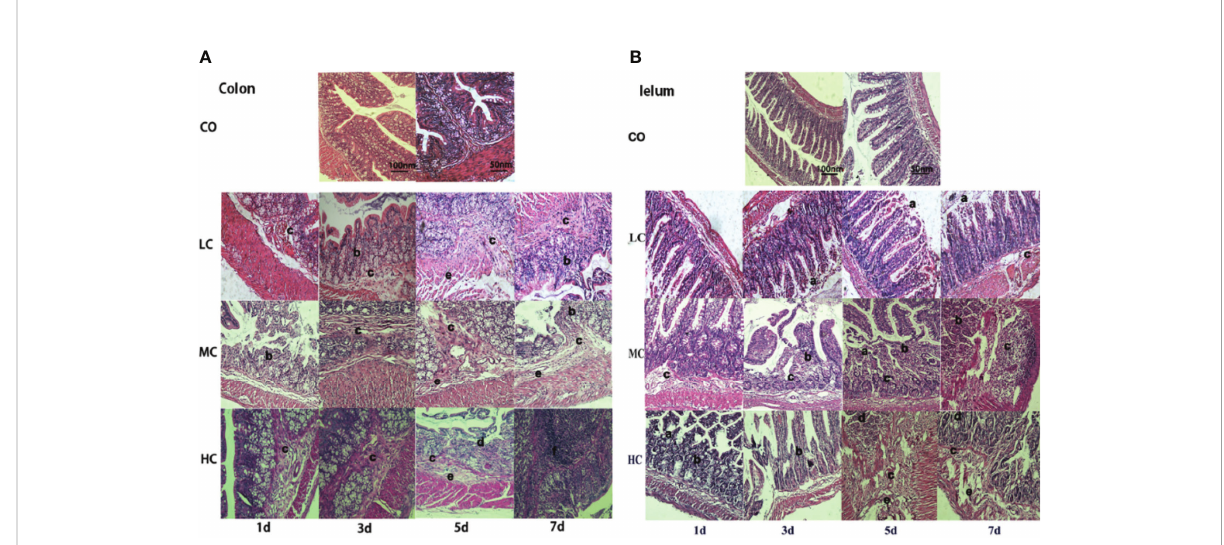
FIGURE 2 Morphological injuries of issues ( A -Colon, B -Iulem) on different days after intraperitoneal injection of c . malonaticus LPS into SD rats. CO, control; LC, low concentration; MC, moderate concentration; HC, high concentration. A -Colon and B -Iulem: slight damage to villus tips (a) , distension and separation of lamina propria (b) , in fl ammatory cytokine in fi ltrates (c) , intestinal structure disorder (d) , edema in mucosa layers and submucosa (e) , intestinal structure seriously disturbed, and high-grade in fl ammatory cytokine in fi ltrates (f)